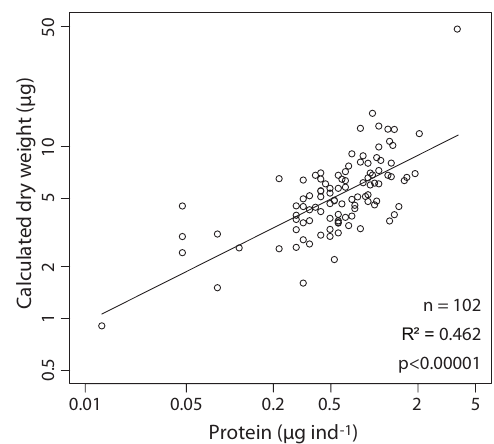
Fig. 5. Calculated dry weight (Eq. 3) calculated for individuals of A. tepida sampled in November 2010 (residual standard er- ror = 0.387, exponential